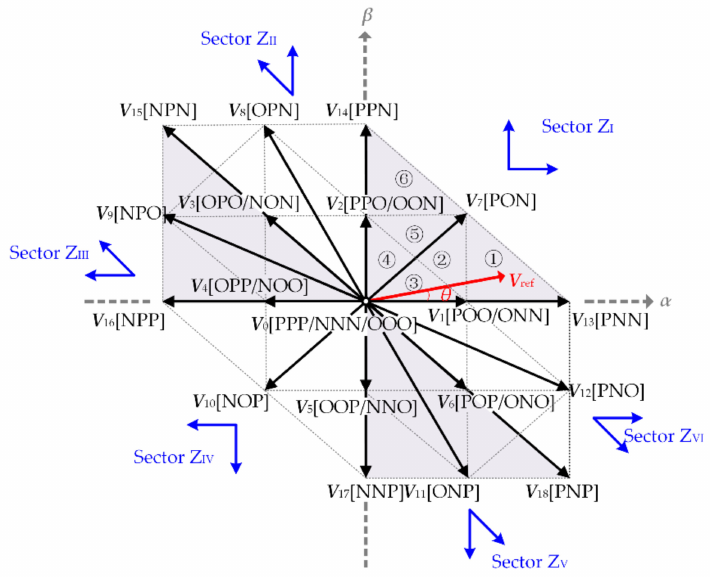
Figure 4. The space vector diagram of the NPC three-level inverter fed two-phase load.